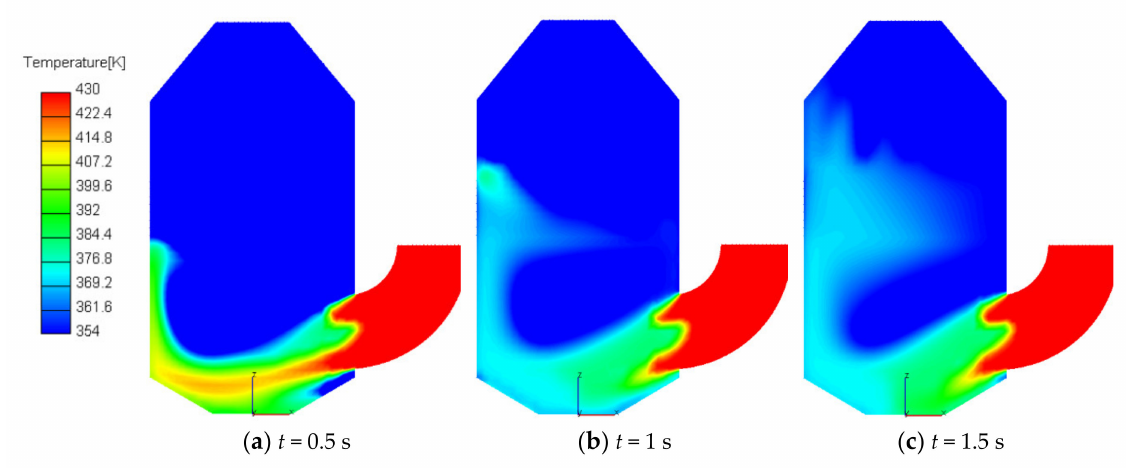
Figure 7. Temperature contours inside the